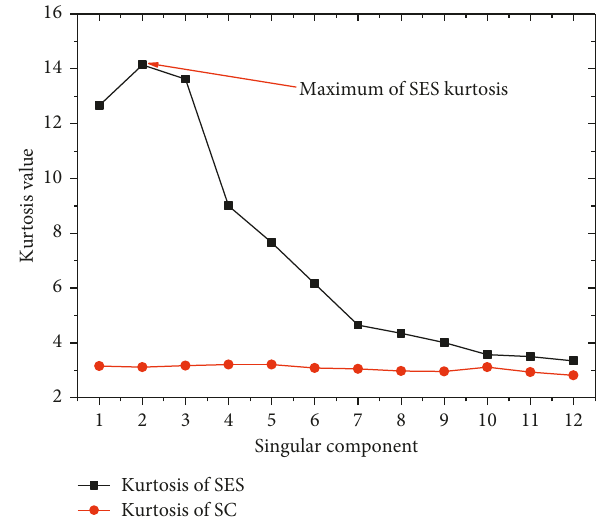
Figure 3: Kurtosis values of each SC and corresponding SES.